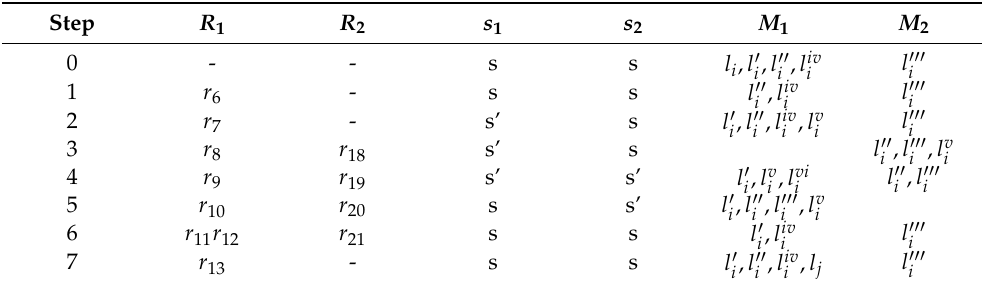
Table 1. The application of rules in R 1 and R 2 , the evolution of channel states s 1 and s 2 , and the rewriting of multisets M 1 and M 2 in membrane 1 and 2, respectively. During the simulation of a SUB